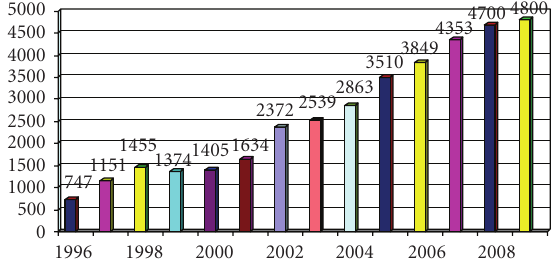
Figure 1: Sedation volume at Hadassah Hospital,